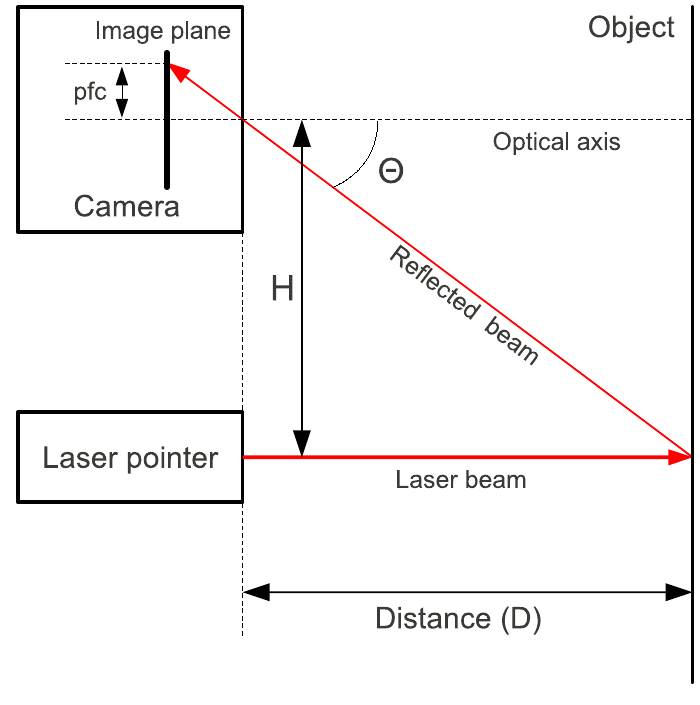
Figure 7. Distance measurement system using a camera and a laser pointer. H is the distance between the camera optical axis and the laser pointer, D the distance between the camera and the object, theta is the angle between the camera’s optical axis and the laser reflected by the object. pfc (pixels from center) is the distance in pixels from the center of the image and the red dot. Figure adapted from Danko and Portugal-Zambrano